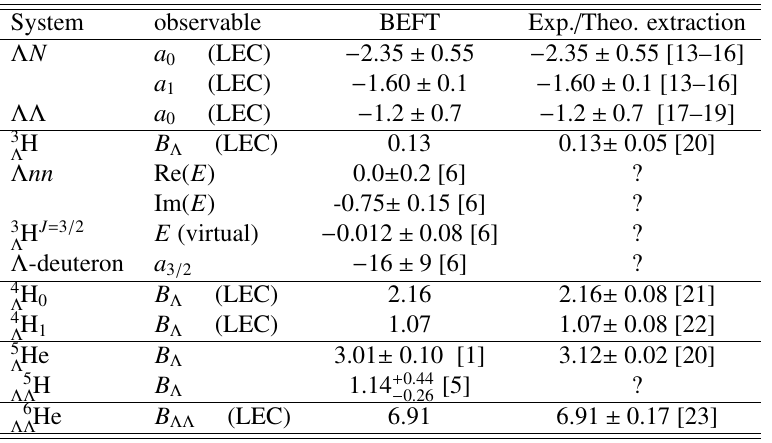
Table 1. Compilation of the experimental data reproduced or predicted by the BEFT. Here, a J is the scattering length with J being the channel’s total angular momentum, E is the state’s energy, B λ the Λ particle separation energy and B ΛΛ the double Λ separation energy. All energies are given in MeV, scattering lengths are given in fm. Observables used to fit the LECs are denoted by